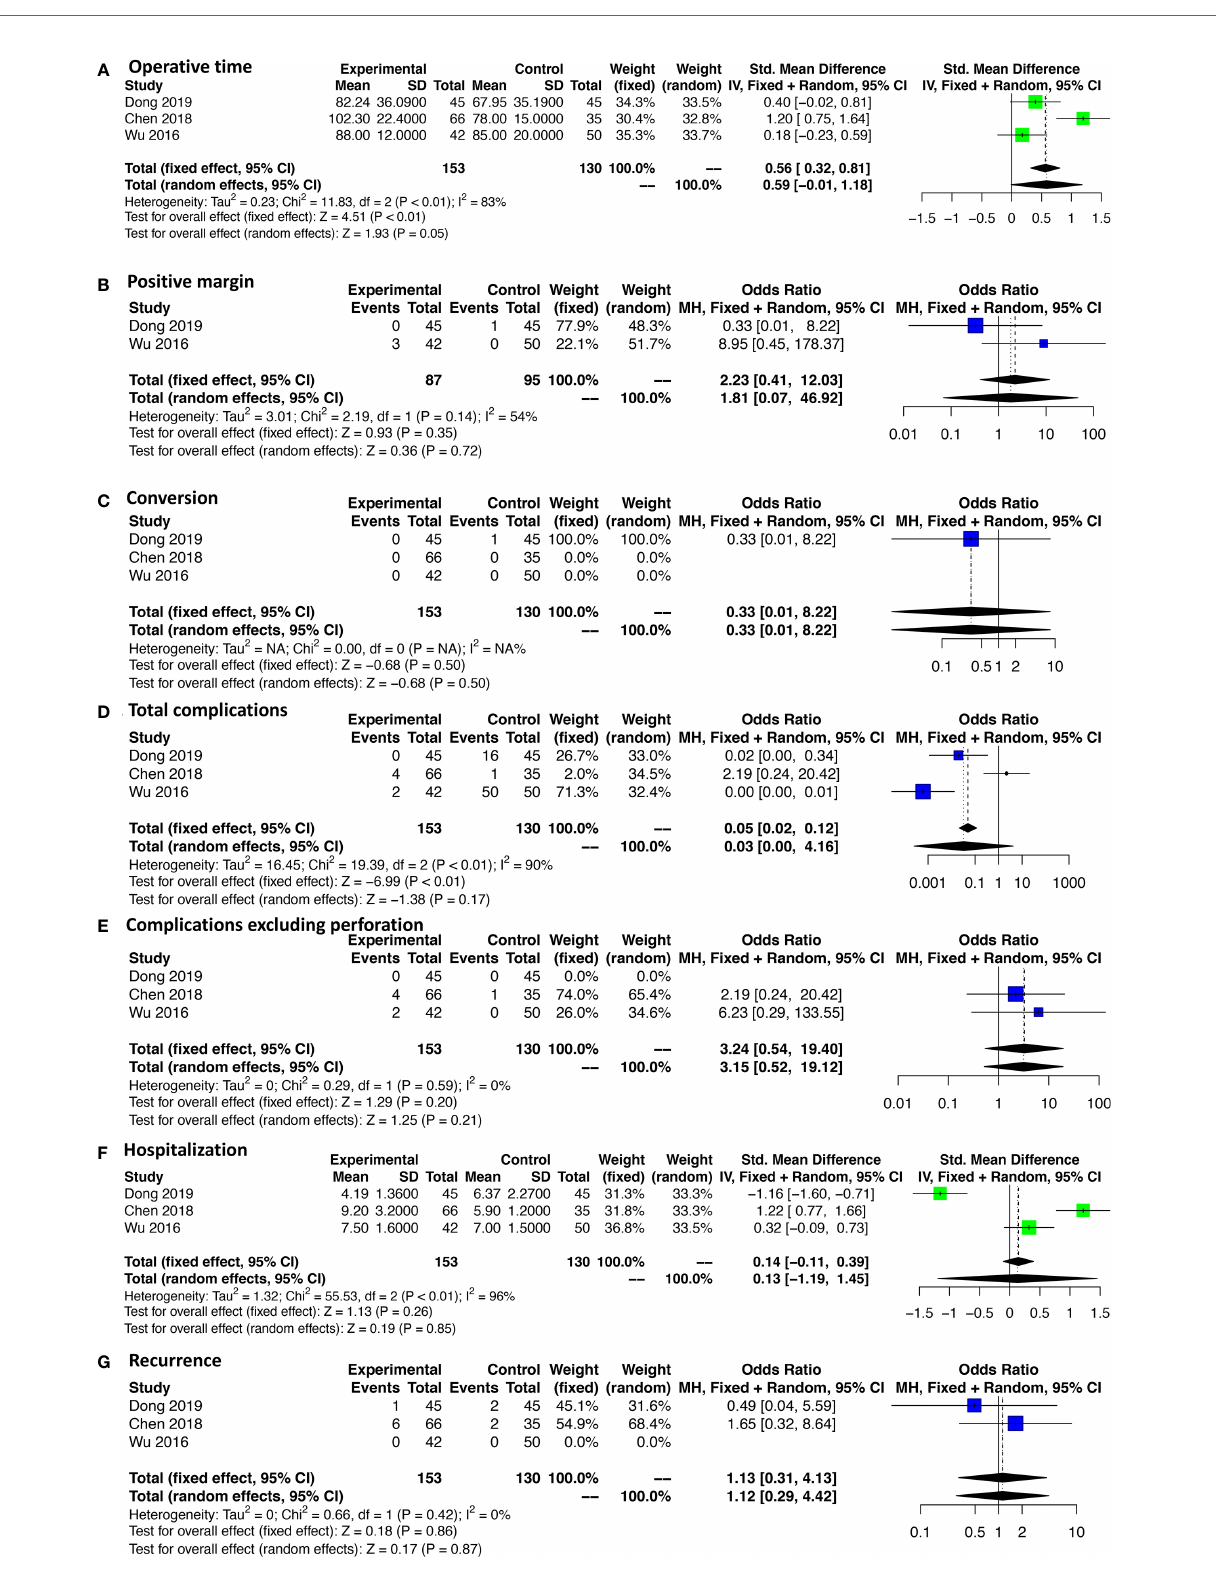
Frontiers in Oncology |